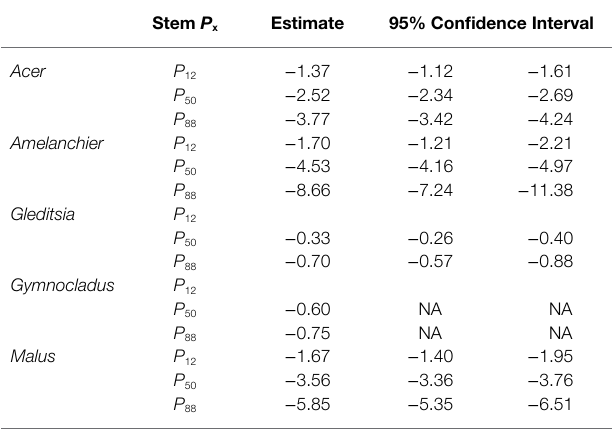
TABLE 2 | Vulnerability curve parameters for five cultivars. Stem P 12 , P 50 , and P 88 are modeled from the vulnerability curves shown in Figure 2 . Stem P x Estimate 95% Confidence